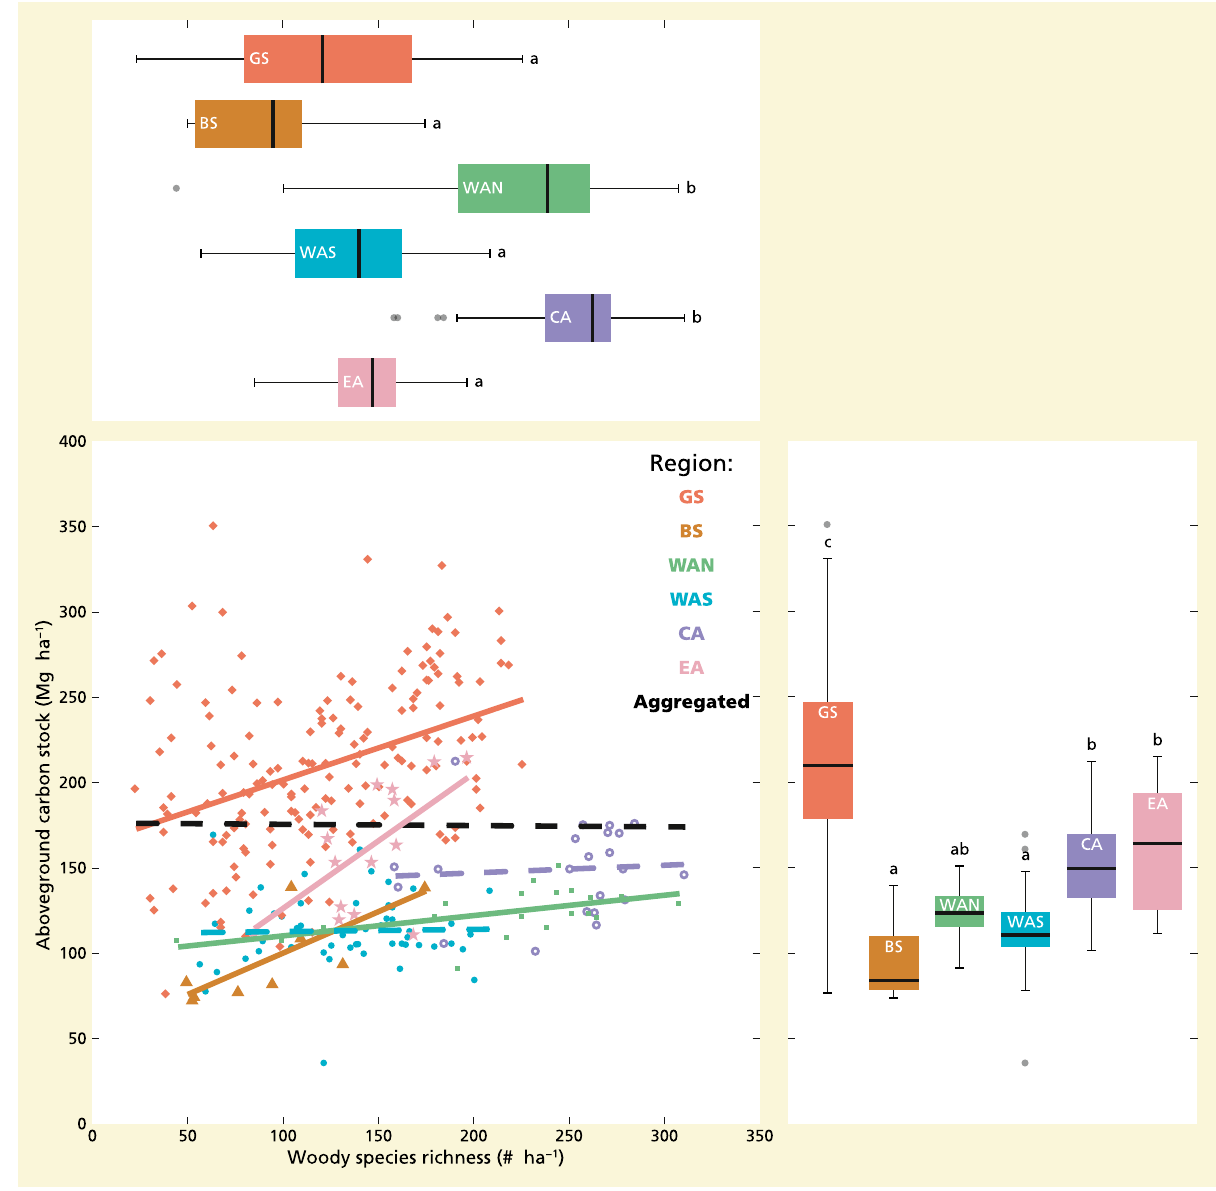
Figure 2. Visualisation of linear bivariate relationships between carbon stock and species richness for different biogeographical regions in the Amazonia dataset. Relationships across all biogeographical regions (Agg., n = 283): black line; for Guiana Shield (GS, n = 165): red line, Brazilian Shield (BS, n = 9): dark yellow line, north- western Amazonia (WAN, n = 21): green line, south-western Amazonia (WAS, n = 51): light blue line, central Amazonia (CA, n = 22): purple line, and eastern Amazonia (EA, n = 15): pink line. Showing boxplots for carbon stock (bottom left) and species richness (upper panel) across the regions with differences according to Tukey post-hoc tests indicated by different letters. Model details are included in Tables